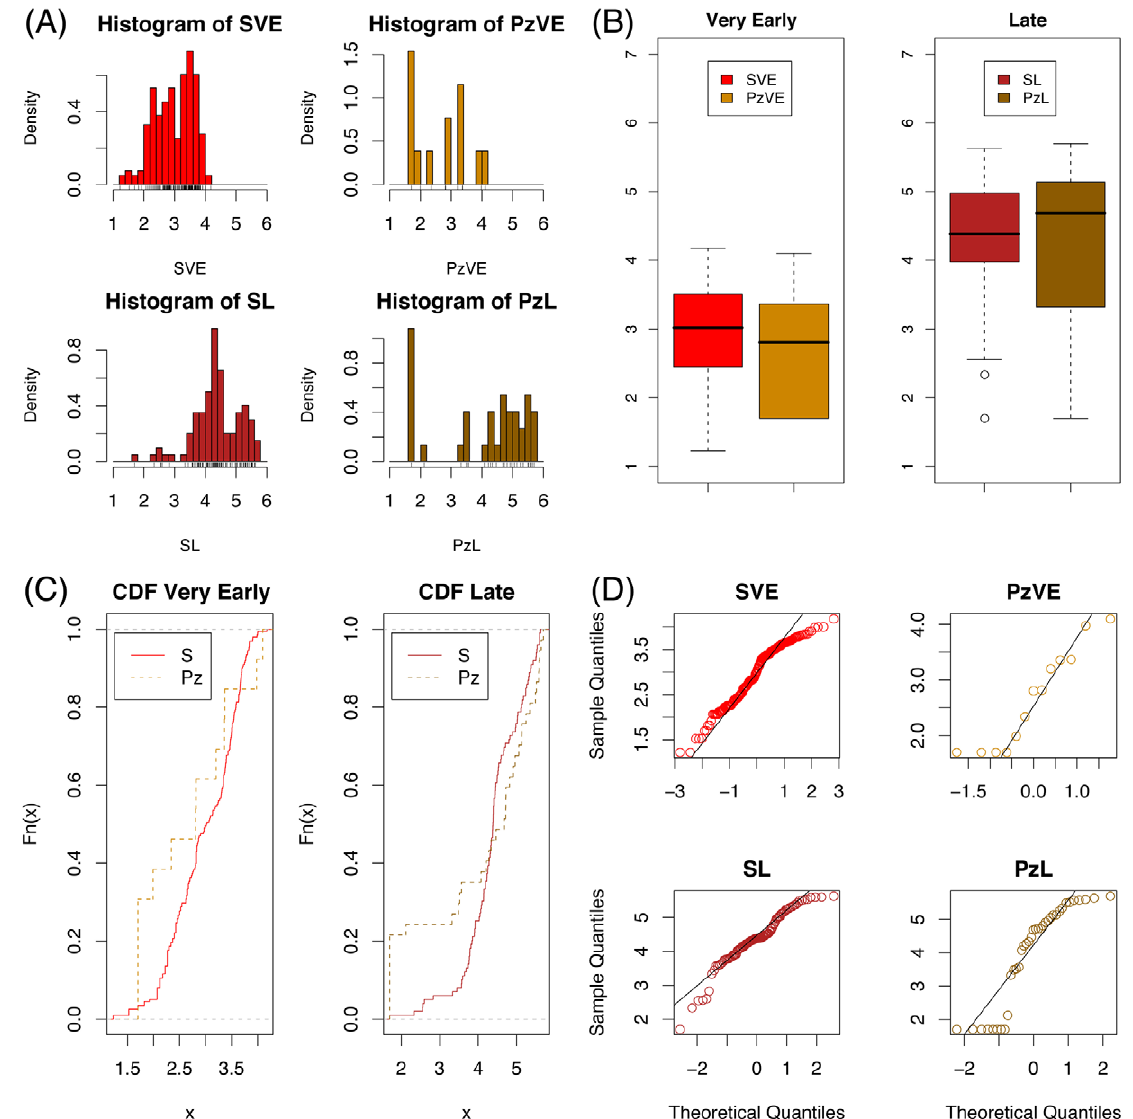
Figure 2. Clinical and simulated data. Statistical summary of clinical and simulated V 4 for both very-early and late settings. Panel A shows how the data is distributed. In panel B the ‘‘whiskers’’ indicate the lower, median and upper quartile while largest and smaller values are shown by dashed lines. Outliers are shown as small circles. Panel C shows the cumulative distribution functions for the two groups. Panel D reports the normal probability plots (or quantile-quantile plots) for comparison to normal distributions. Legend: SVE = simulated very early, PzVE = patients very early; SL = simulated late, PzL = patients late.